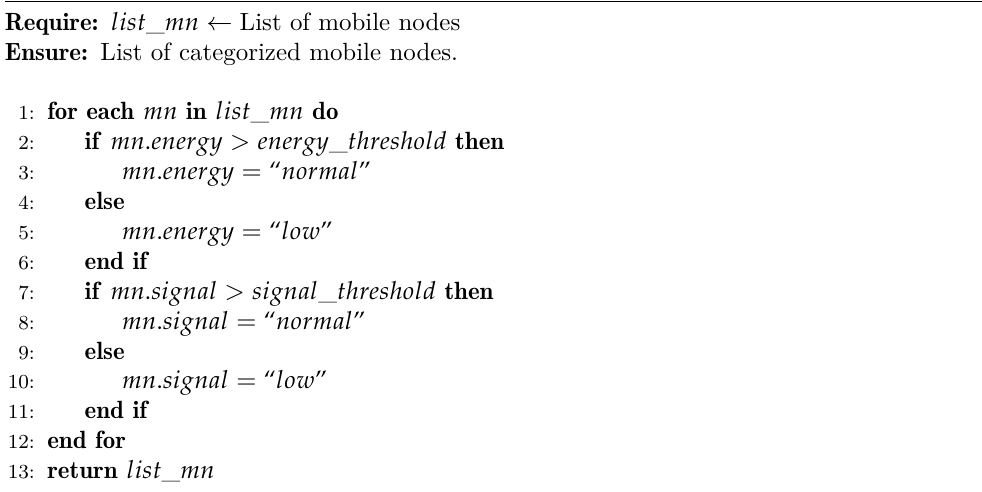
Algorithm 1 Critical resources’ state